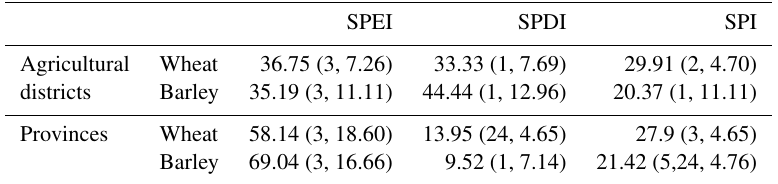
Table 2. Percentage of analyzed agricultural districts and provinces where wheat and barley are cultivated, for which the maximum cor- relations with the multi-scalar indices were found. Information in parentheses shows the timescale at which the provinces and agricultural districts correlate most and the percentage of the provinces and